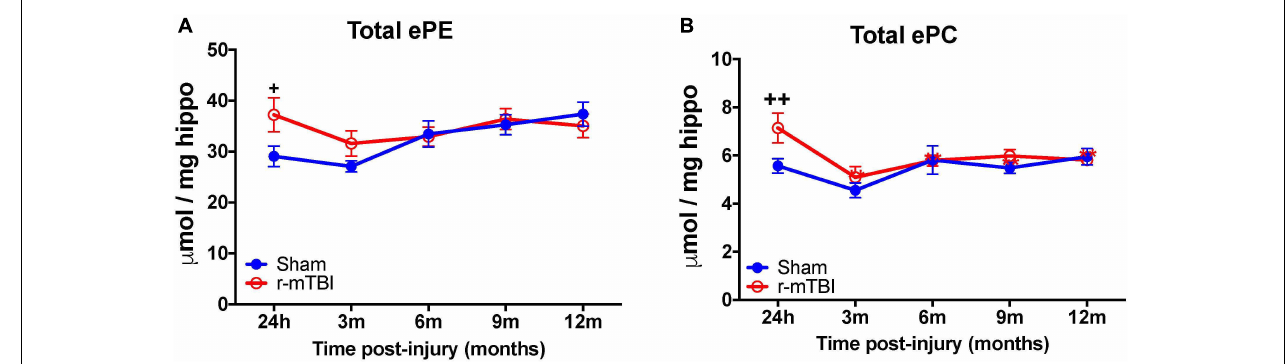
FIGURE 4 | Total etherPE and ether PC levels in the hippocampus of repetitive-mTBI hTaumice. Significant changes in total etherPE (A) and etherPC (B) lipid species in the hippocampus etc. of a model of repetitive-mTBI in hTau mice. Sample size for all groups across all time points is n = 4. All data represent mean µ M per (5.5 mg) wet weight ± SEM. Individual molecular lipid species were quantified by liquid chromatography/mass spectrometry and were summed after LipidomeDB analyses to generate total etherphospholipid levels. Asterisks represent + P < 0.05, ++ P < 0.01 for comparisons between sham/r-mTBI mice. ePE, etherphosphatidylethanolamine; ePC,